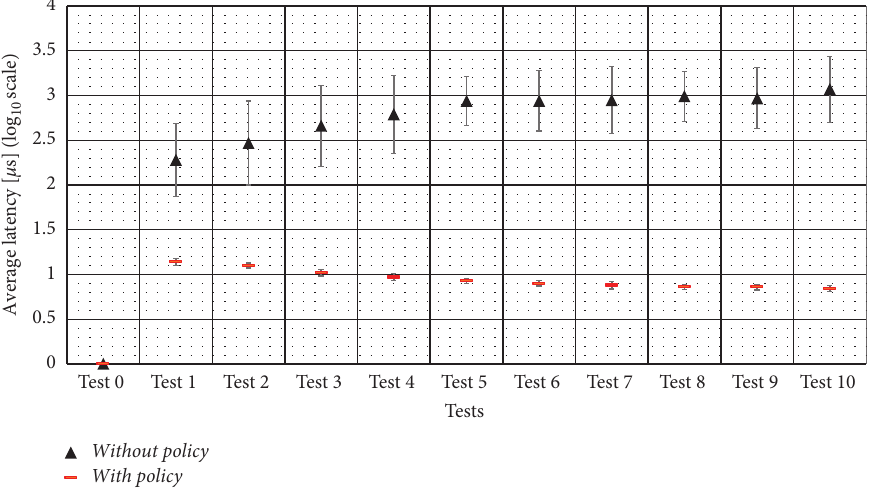
Figure 7: Average of network layer latency.